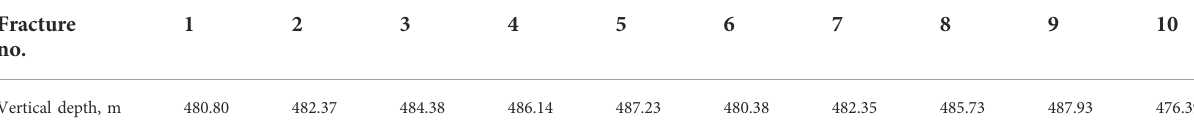
TABLE 4 Hydraulic fracture location data of bow horizontal well. Fracture no. Vertical depth, m